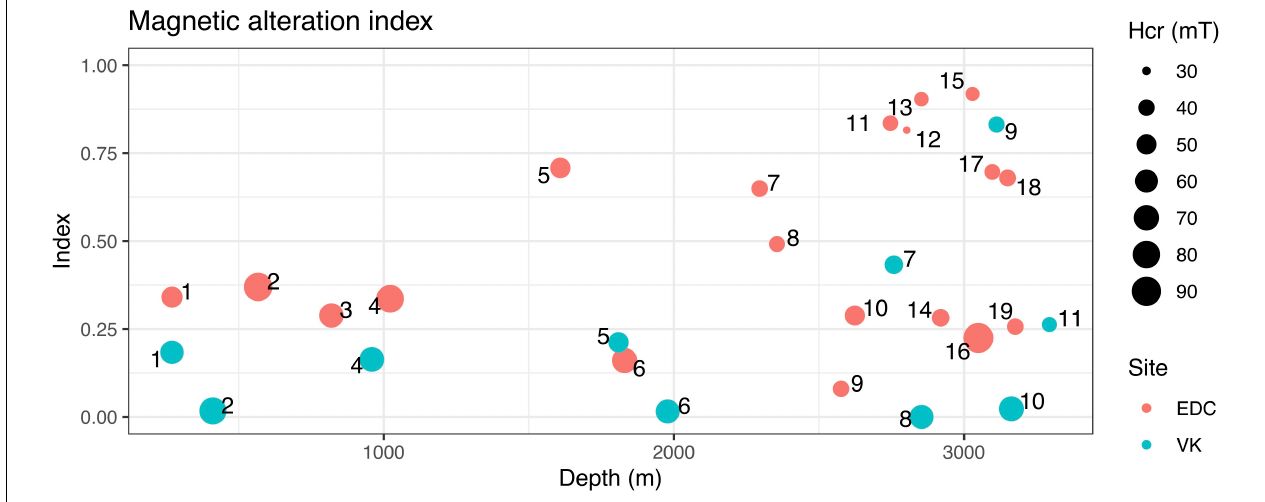
FIGURE 8 | Alteration index representing the normalized absolute difference between SIRM dust and its estimated pristine value, which is computed from IDC data averaged within each MIS ( Table 1 ), see text for details. Alteration index close to zero indicates a SIRM dust similar to that measured in the Holocene and LGM samples at VK. Values close to unity indicates anomalously large SIRM dust that could not be explained by the magnetization of PSA samples. Symbols size is proportional to H cr and numbers indicate the M.I.S. from which one can deduce the average age of the group of samples ( Table 1